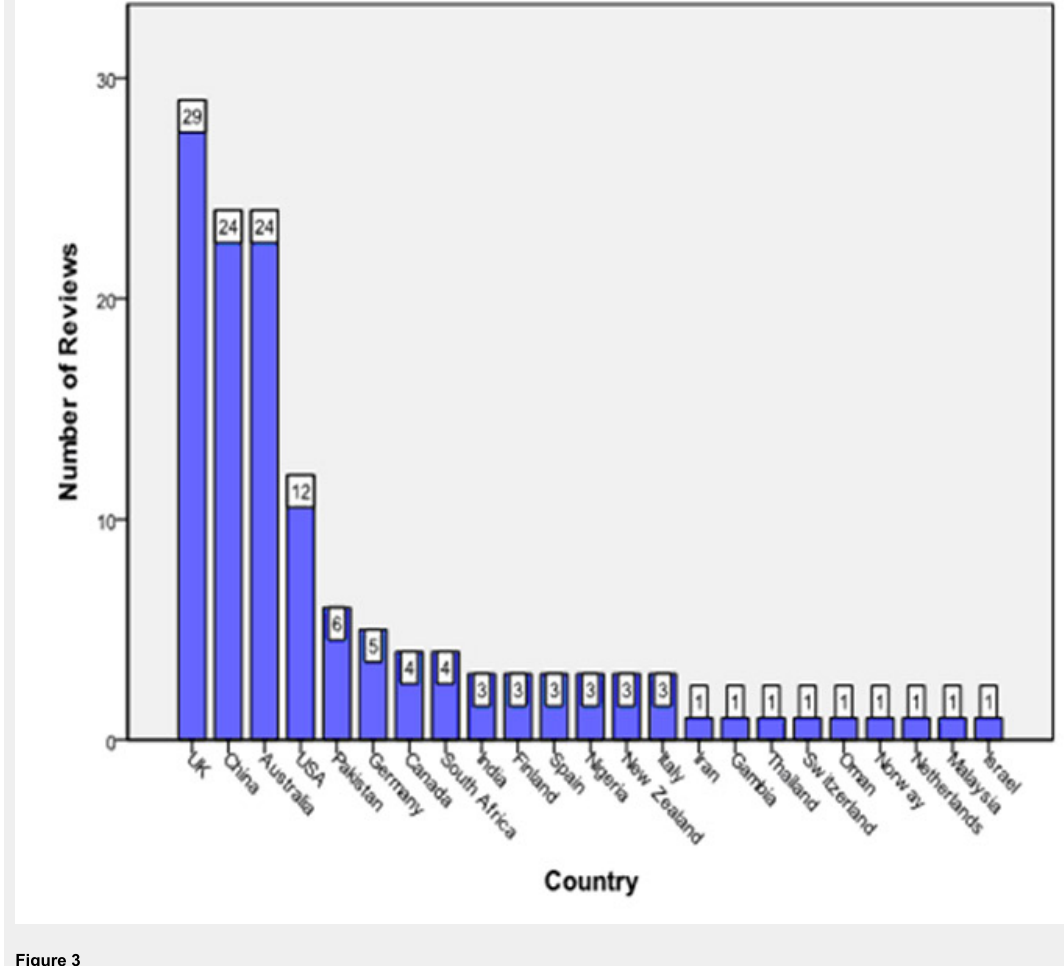
Figure 3 Origin of Cochrane reviews by